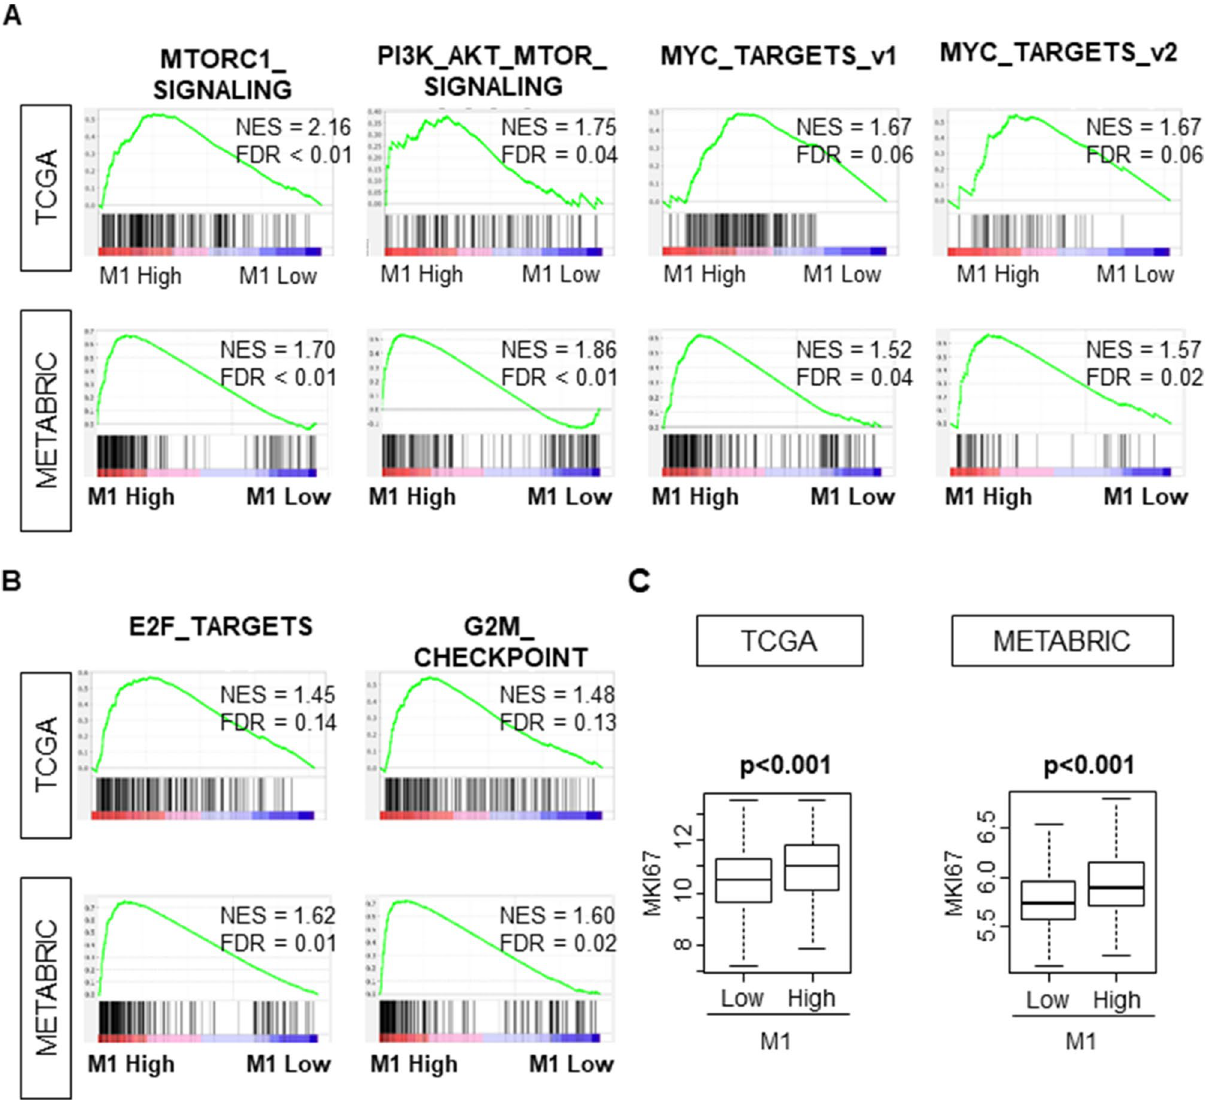
Figure 4. “M1” high tumors were associated with highly proliferative features. ( A ) “M1” high tumors were associated with the gene sets related to cell proliferation. ( B ) “M1” high tumors were associated with the gene sets related to cell proliferation. ( C ) “M1” high tumors were associated with Ki-67 transcriptome analysis in both TCGA and METABRIC cohort. TCGA (n = 1065, High = 533, Low = 532). METABRIC (n = 1903, High = 953, Low = 950). The statistical significance of GSEA was determined using false discovery rate (FDR) of